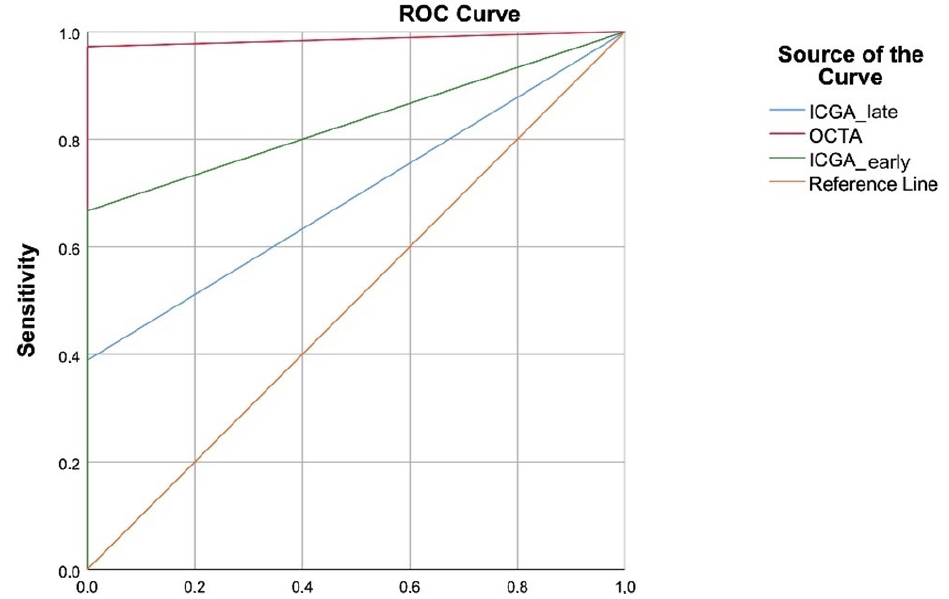
Figure 5. The receiver operating characteristic (ROC) curve compares the sensitivity and specificity of OCTA and ICGA of OCTA and ICGA techniques.